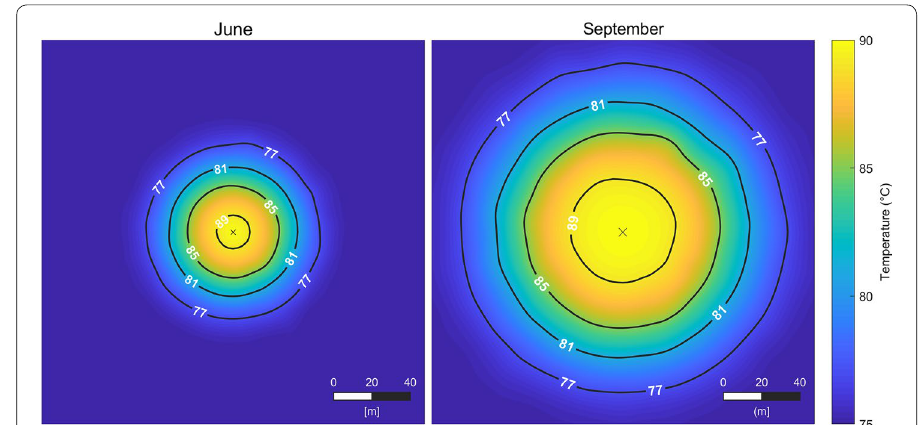
Fig. 5 Contour plot of affected area by 90 °C injection; after a 1-month storage period (left); after a 4-month storage period